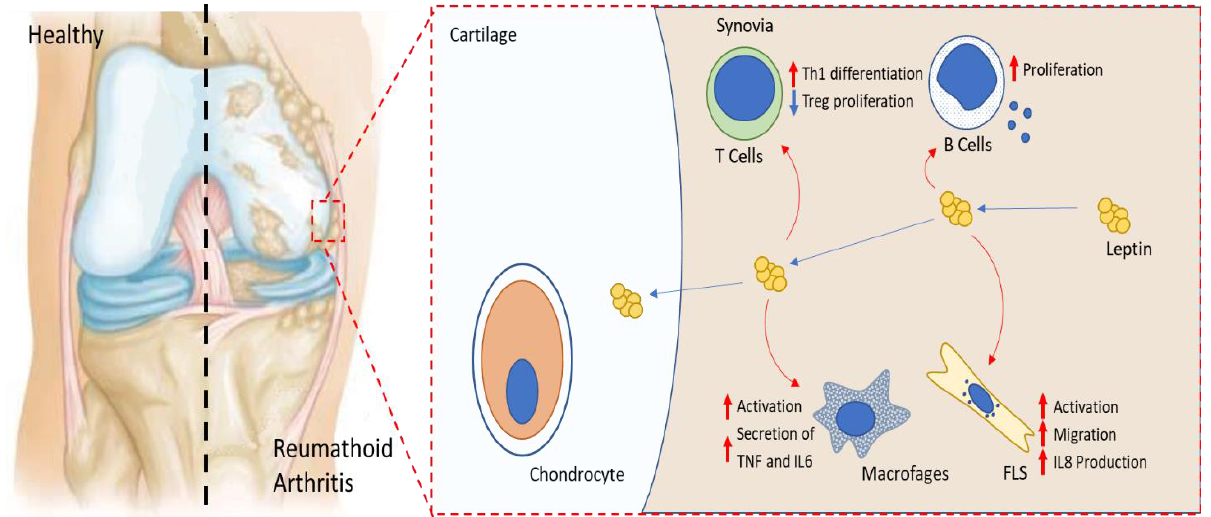
Figure 2. Leptin effect on RA key effector cells. Leptin enhances Th17 proliferation, B cell activation, and macrophage production of TNF and Il-6. It activates FLS migration and secretion of IL-8. It acts on chondrocytes by activating NOS expression and adhesion molecules leading to lymphocyte infiltration to the inflamed joints and degradation of articular cartilage.